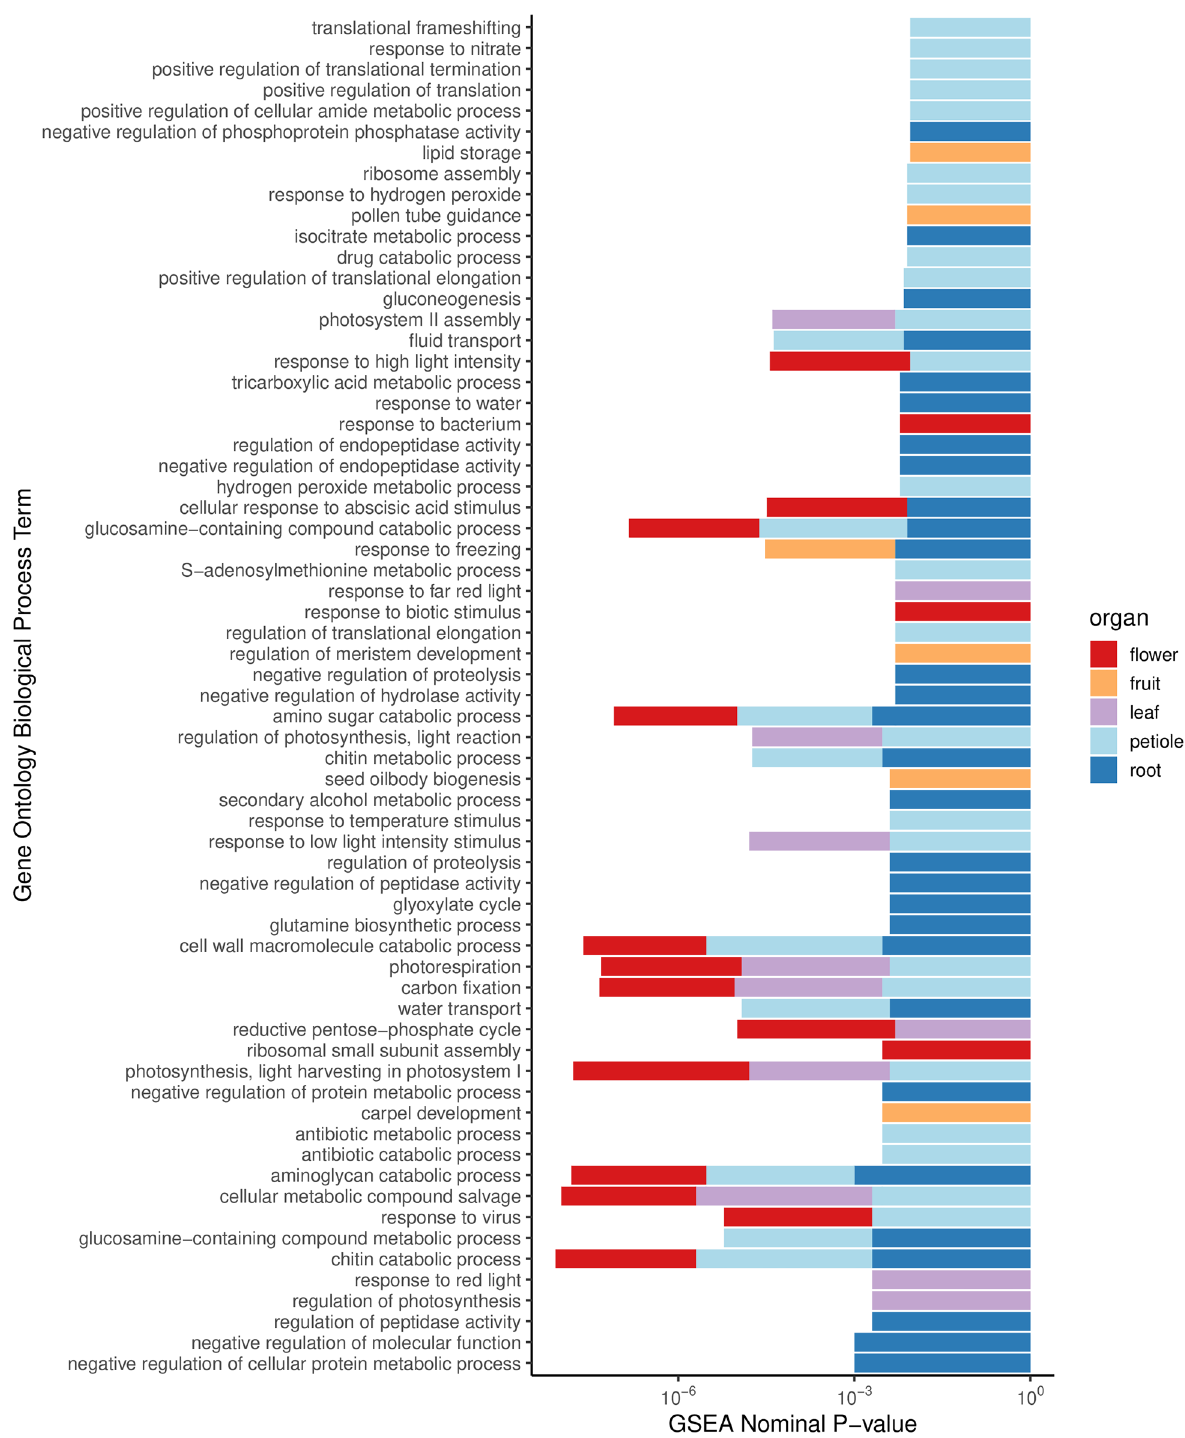
Figure 4. Gene ontology biological process terms in the genes expressed in each organ, found using gene set enrichment analysis (nominal p value < 0.01). The height of the bar reflects the negative logarithm (base 10) of the p value, and the colours are used to indicate the organs. The R package ggplot (https:// ggplo t2. tidyv erse. org) was used to draw this